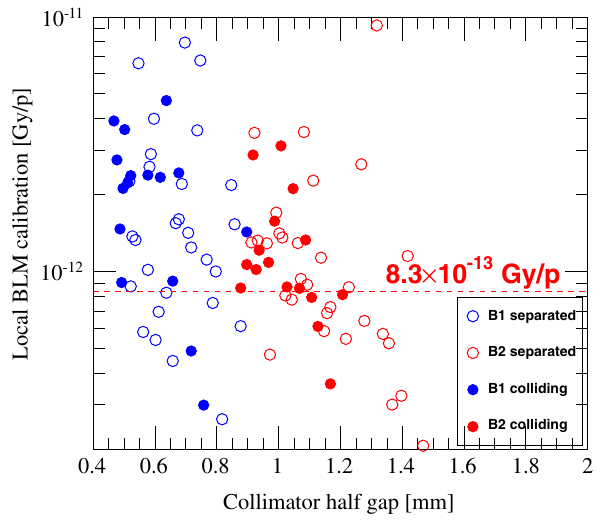
FIG. 9. The calibration factors calculated for each loss spike in units of Gy = p , as a function of the collimator half gap in mm. The red dotted line indicates the calibration factor found in the 2011 scraping study for reference.